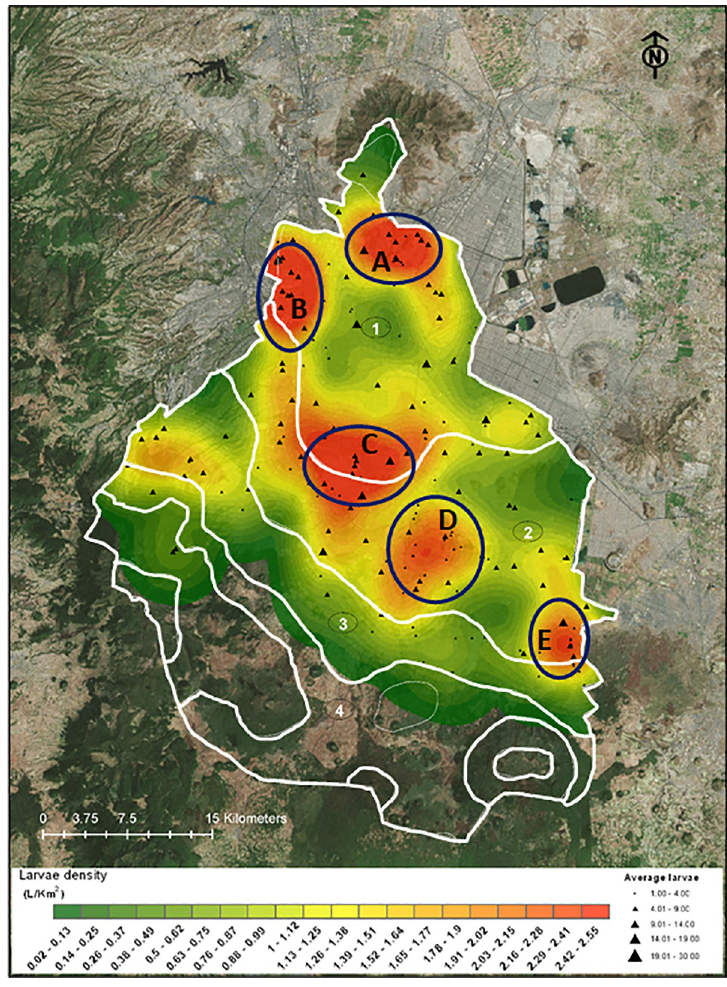
Fig 2. Collecting sites and hotspots. Six cluster of species (clusters A, B, C, D and E) are shown. Numbers indicate microclimates: 1) 5˚C—28˚C, 2) 4˚C—26˚C, 3) 3˚C—24˚C and 4) 2˚C—22˚C. Larvae density (larvae/km2; green- red areas) and average collected larvae (black triangles) are